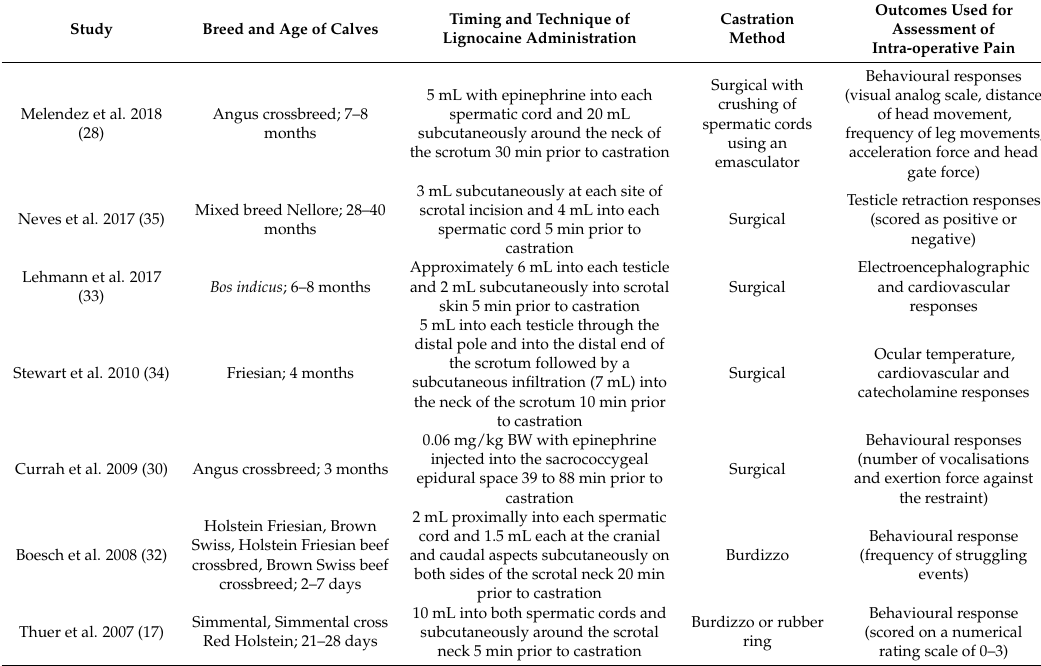
Table 1. Methodology in previous studies investigating the efficacy of lignocaine HCl (20 mg/mL) for pain relief during castration of